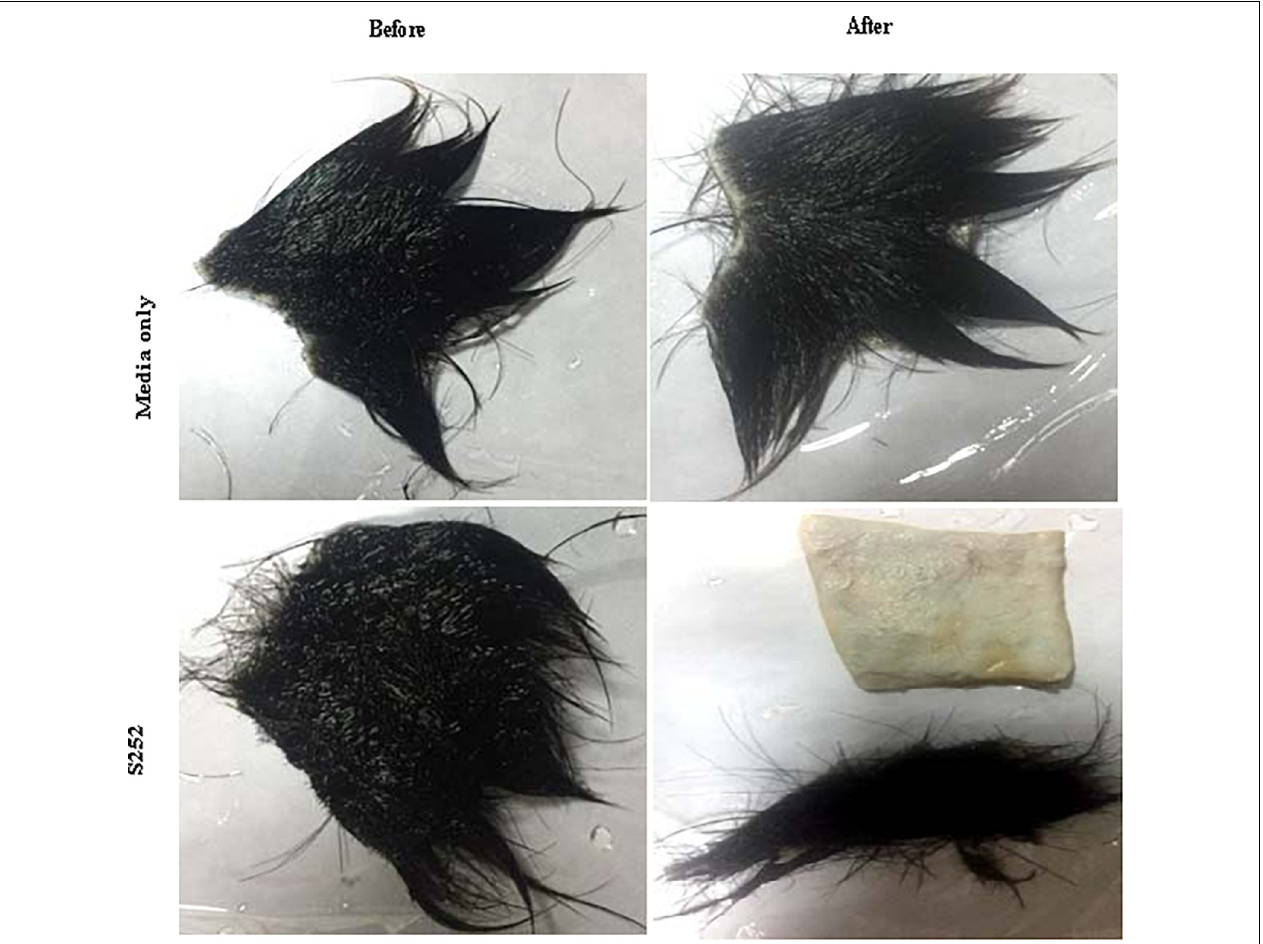
FIGURE 8 | Dehairing potential of PyCP. Goat skin was incubated for 24 h at 40 ◦ C with PyCP.